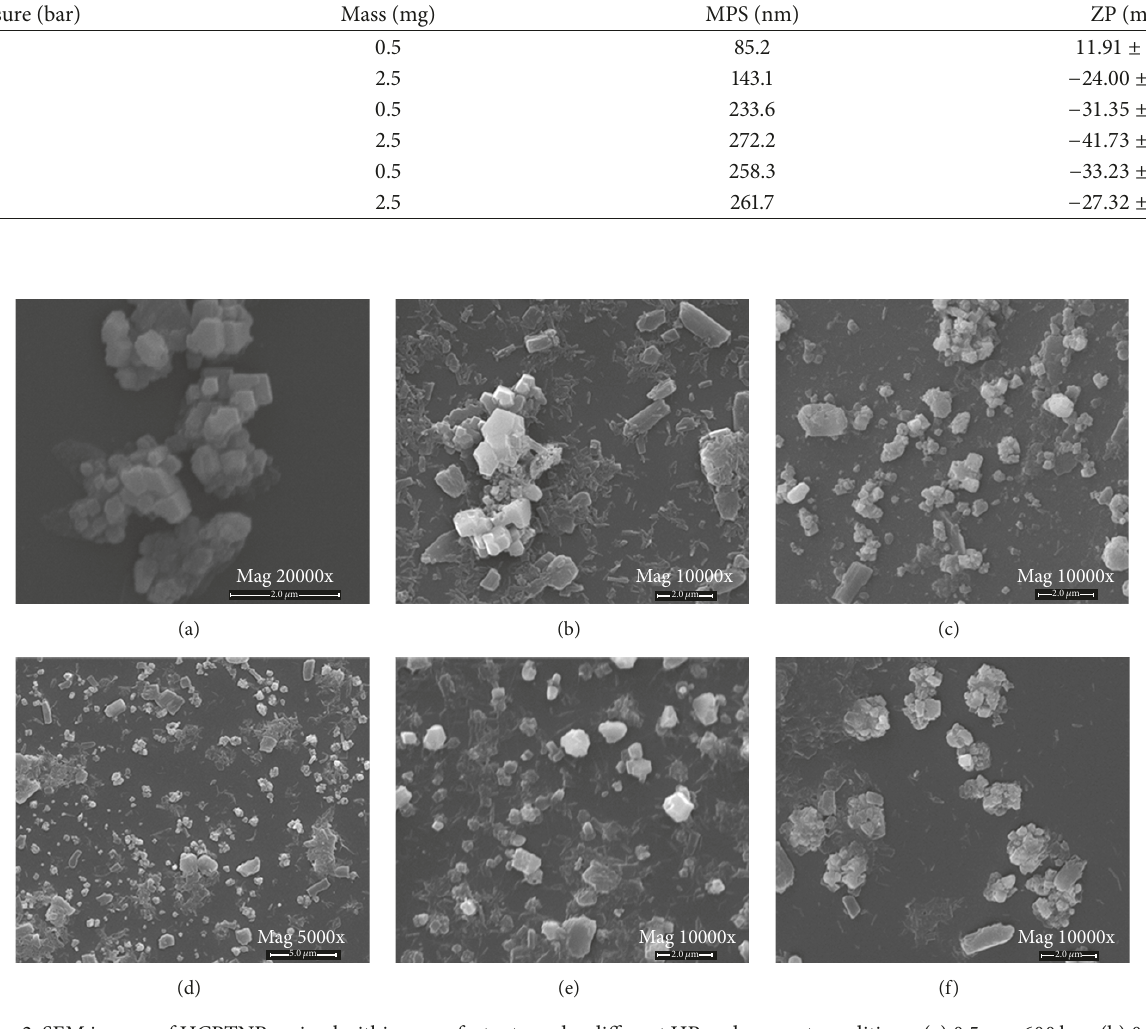
Figure 2: SEM images of HCPTNPs using lecithin as surfactants under different HP and amount conditions: (a) 0.5 mg, 600 bar; (b) 0.5 mg, 800 bar; (c) 0.5 mg, 1000bar; (d) 2.5 mg, 600 bar; (e) 2.5 mg, 800 bar; (f) 2.5 mg,